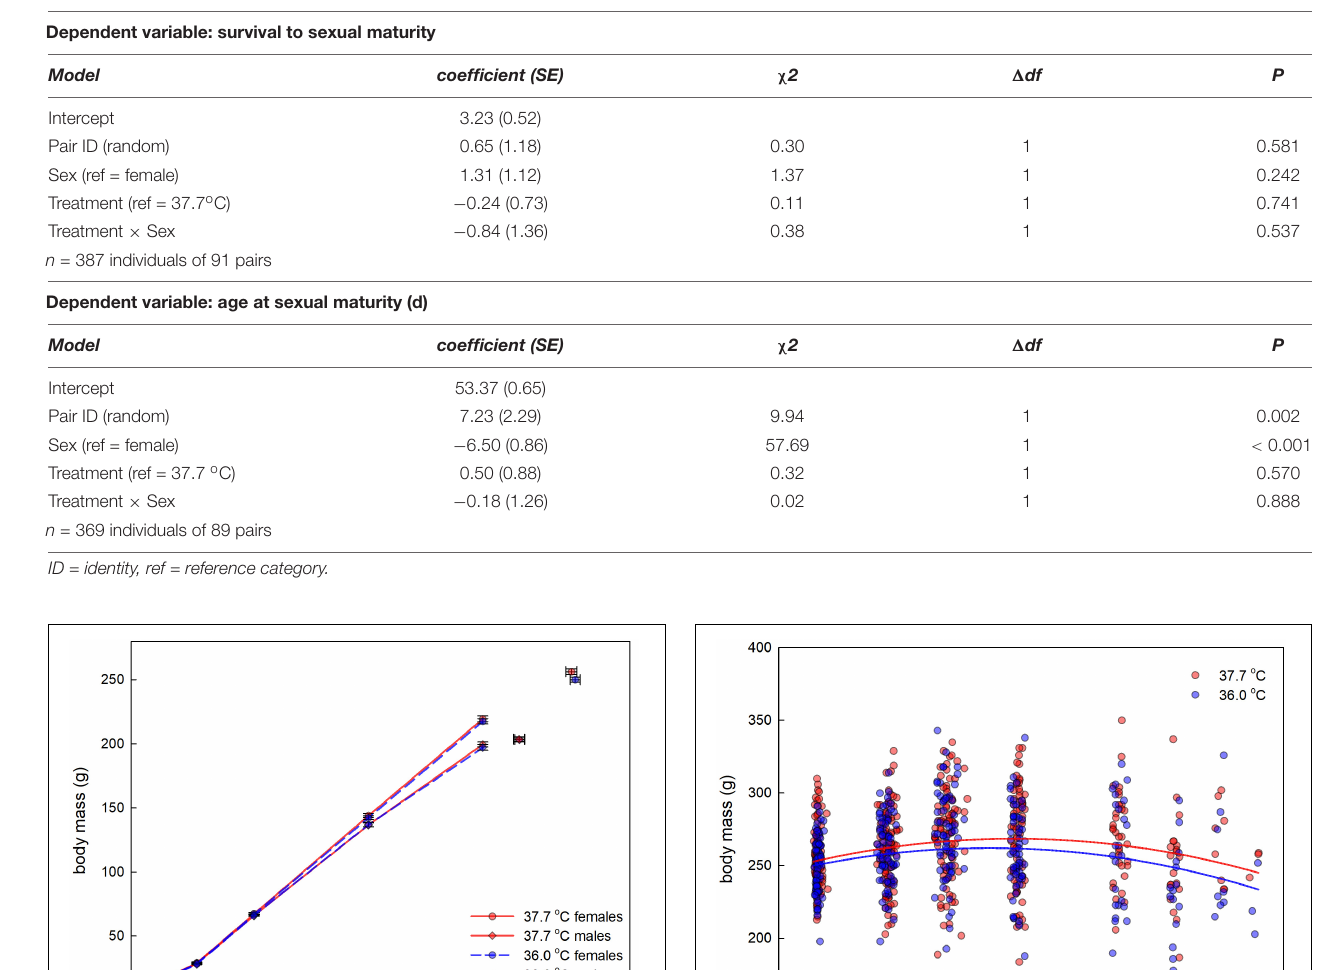
TABLE 2 | Summary of (generalized) linear mixed models testing for effects of incubation treatment on sex-specific survival to sexual maturity, and age at sexual maturity, in Japanese quail chicks.